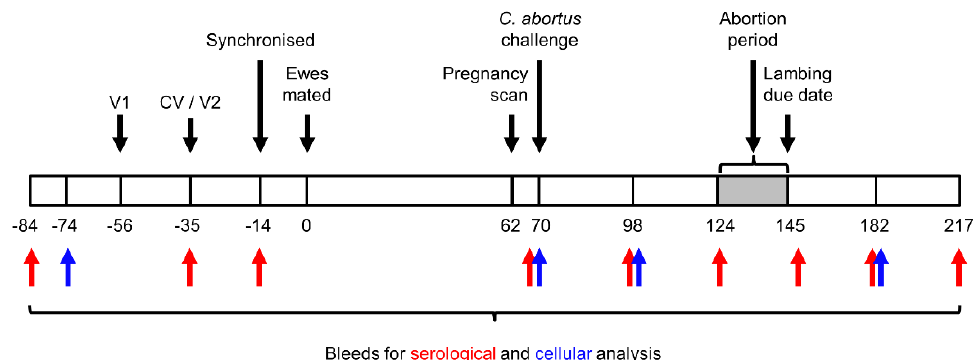
Figure 1. Experimental design. Numbers under bar indicate days prior to or post mating. V1 and V2 indicate timings for first and second vaccinations, respectively. CV indicates when the commercial vaccine was administered.